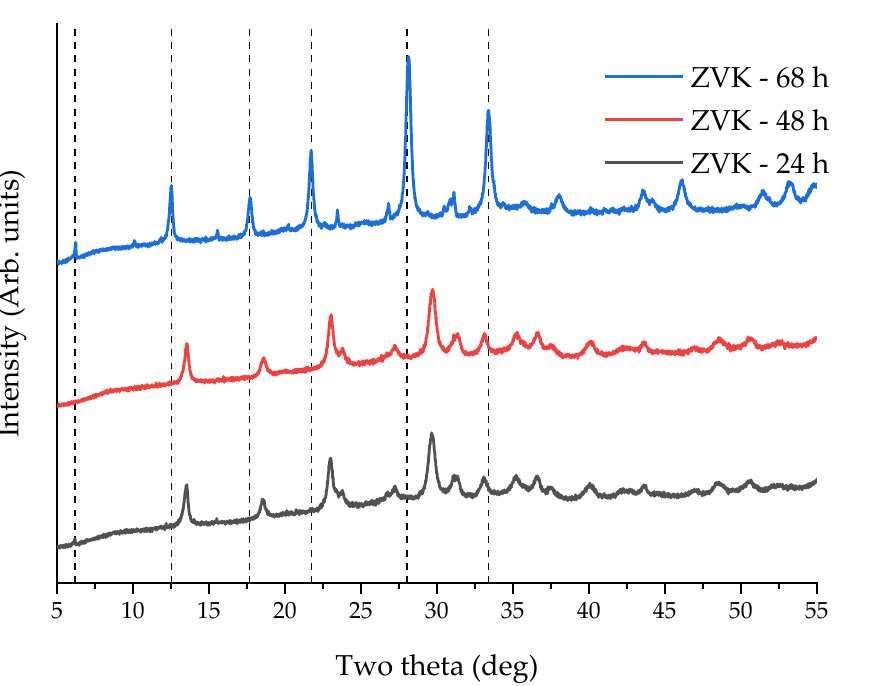
Figure 4. XRD patterns of FAU zeolite from VK for 24, 48, and 68 h ageing at 90 °C for 24 h. Dashed lines represent the main FAU zeolite peaks.